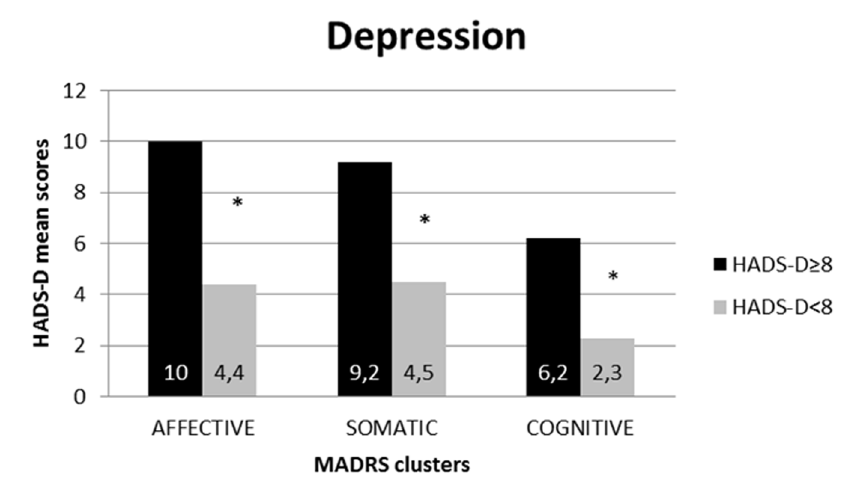
Figure 2. MADRS's clusters distribution according to HADS-depression cut-off. * p <